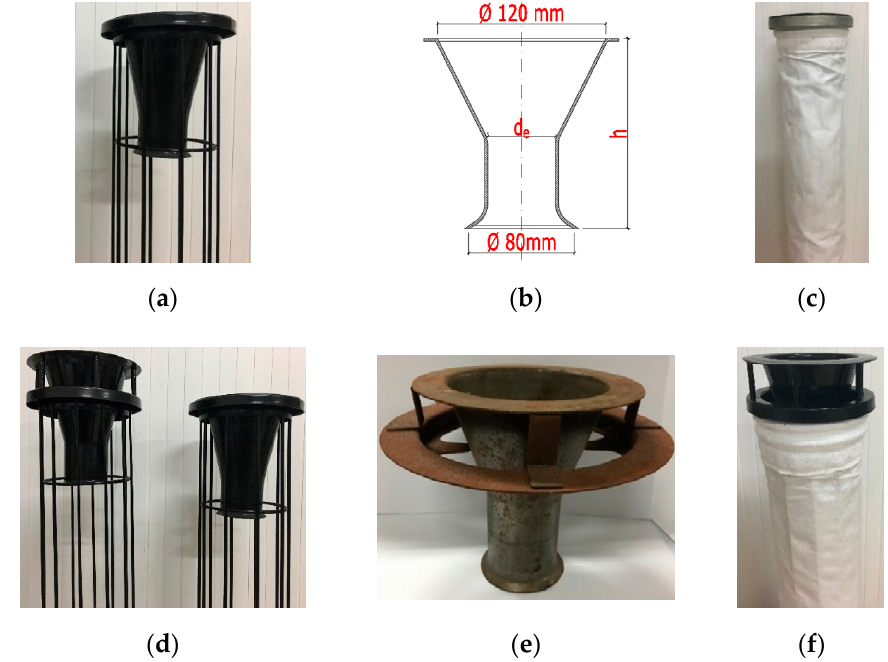
Figure 2. The two types of venturi tubes and their arrangement in the bag cage and filter bag. ( a ) Bag cage with the typical venturi. ( b ) Structural parameters of the typical venturi. ( c ) Typical venturi tube installed in a filter bag. ( d ) Comparison of bag cages adapted with the two types of venturi tubes. ( e ) The new venturi. ( f ) The new venturi tube installed in a filter bag.